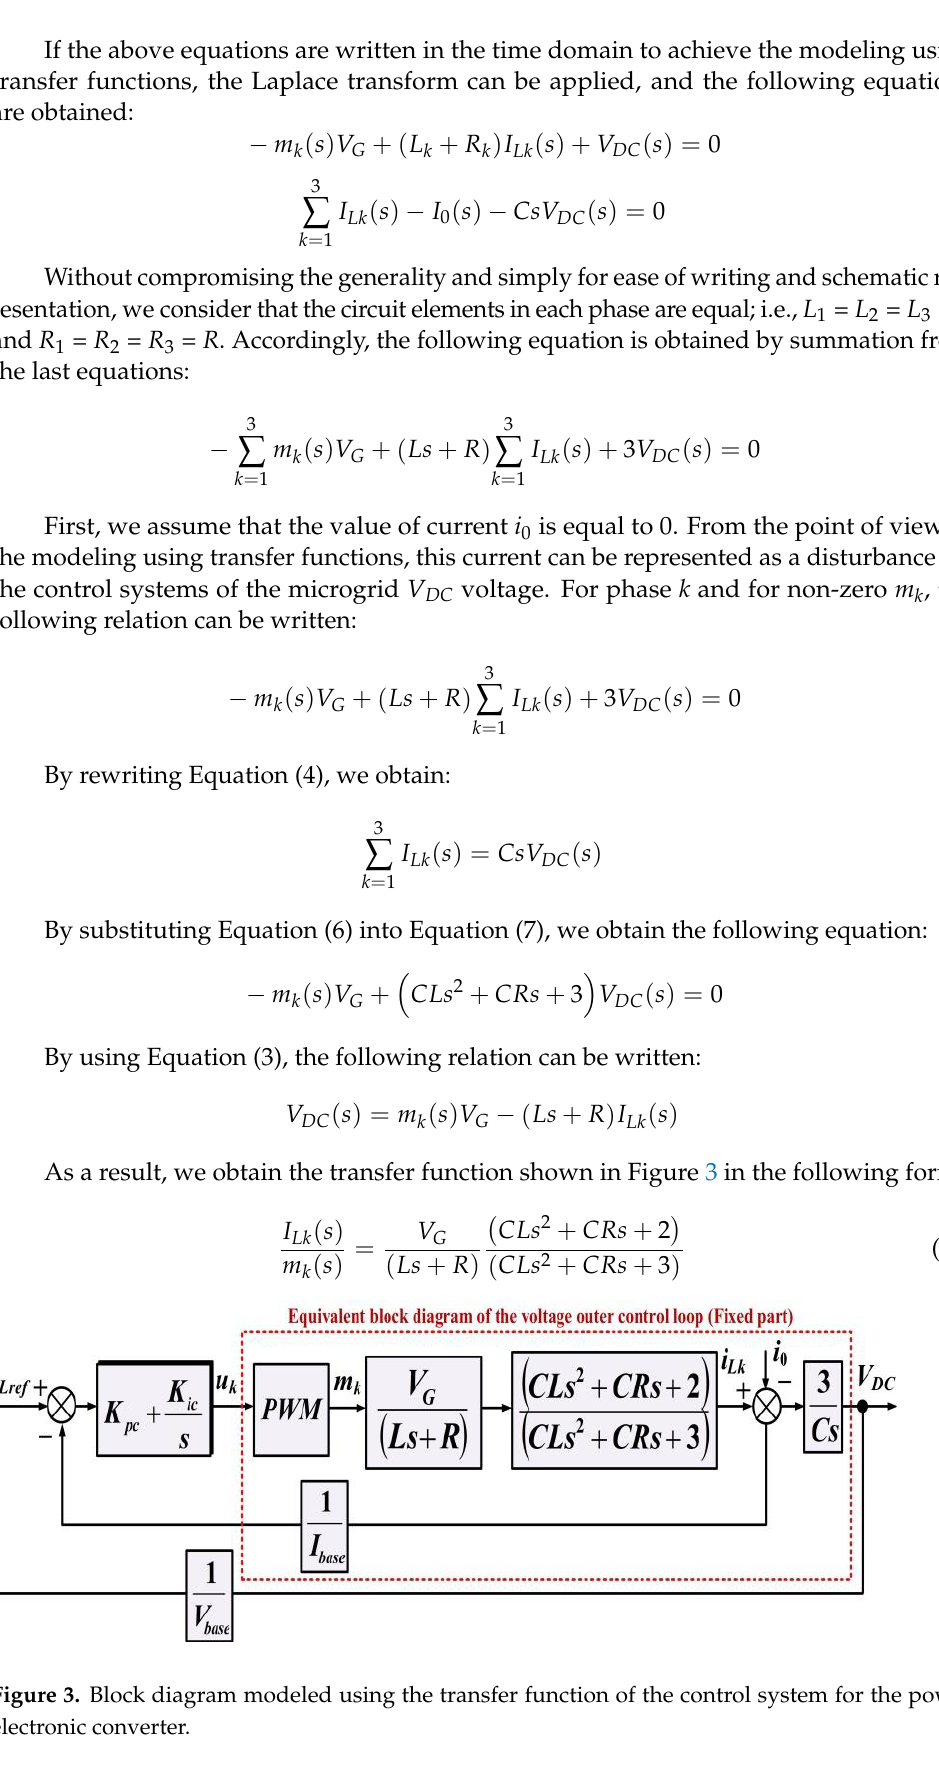
Figure 4. Equivalent block diagram modeled using the transfer function of the inner loop for current regulation. To compare the various control structures using the benchmark from [18,19], for the two types of PI controllers mentioned, we use as prompts the methods proposed in [18,19]; namely, tuning with the Gao method described in [17] and its improvement described in [18]. Thus, considering the bandwidth ω c (for the inner current control loop), the authors of [18] proposed tuning relations as follows: